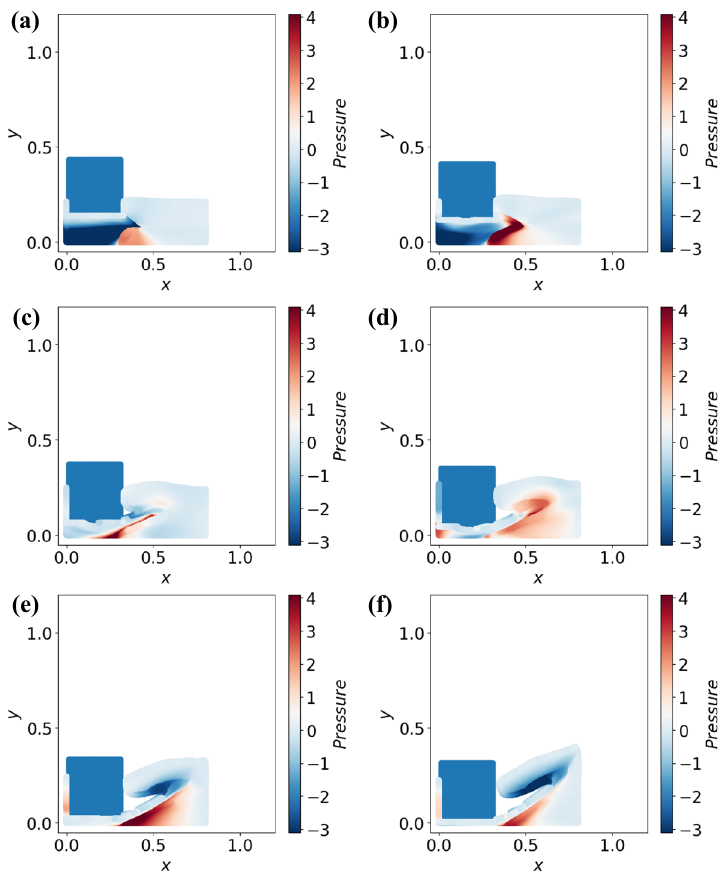
Fig. 10 The surge morphology and pressure distribution diagram. Water depth D = 0 . 21 m and particle density n = 300 / m. Each map corresponds to a different moment. a 3 dt. b 4 dt. c 6 dt. d 7 dt. e 8 dt. f 9